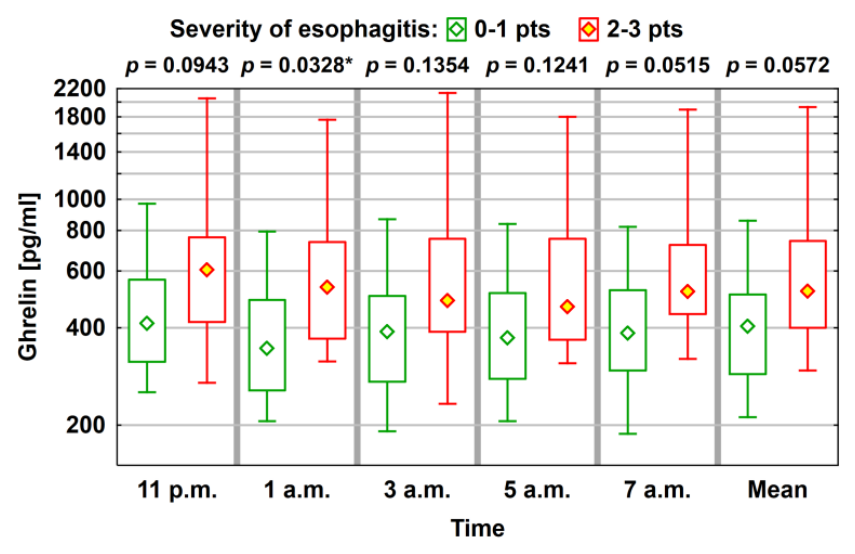
Figure 2. Average level (median) of ghrelin concentration with a typical range of variability (lower and upper quartile) and the total range of variation (statistically significant correlations, where p < 0.05, are marked using *).